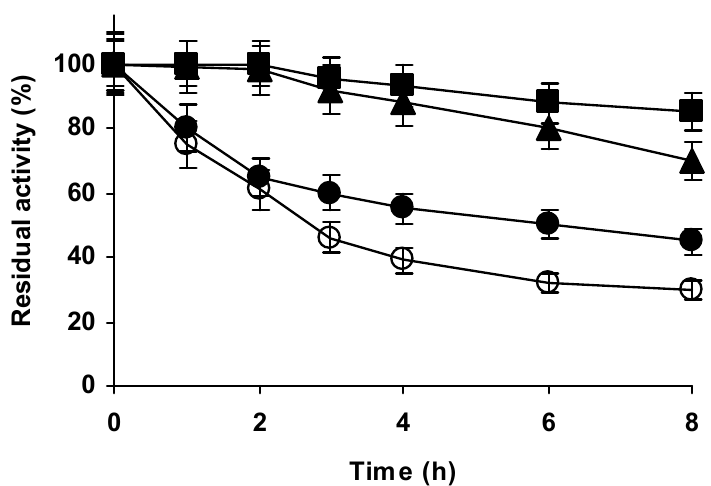
Figure 6. Effect of different glutaraldehyde modifications of Glx-AL-EDA on the inactivation courses at pH 7 and 54 °C. Other specifications are described in methods section. Open circles: aminated enzyme, Solid circles: aminated enzyme modified at pH 7 for 1 h with glutaraldehyde and then reduced; Solid Triangles: aminated enzyme modified with glutaraldehyde at pH 7 for 1 h and then incubated 3 h at pH 8 before reduction, Solid Squares: aminated enzyme modified at pH 7 with glutaraldehyde for 1 h and then incubated at pH 9 for 3 h before reduction.